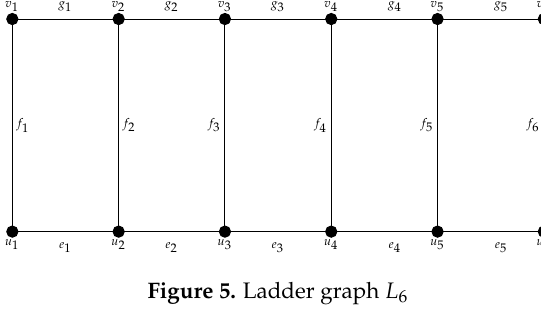
Figure 5. Ladder graph L